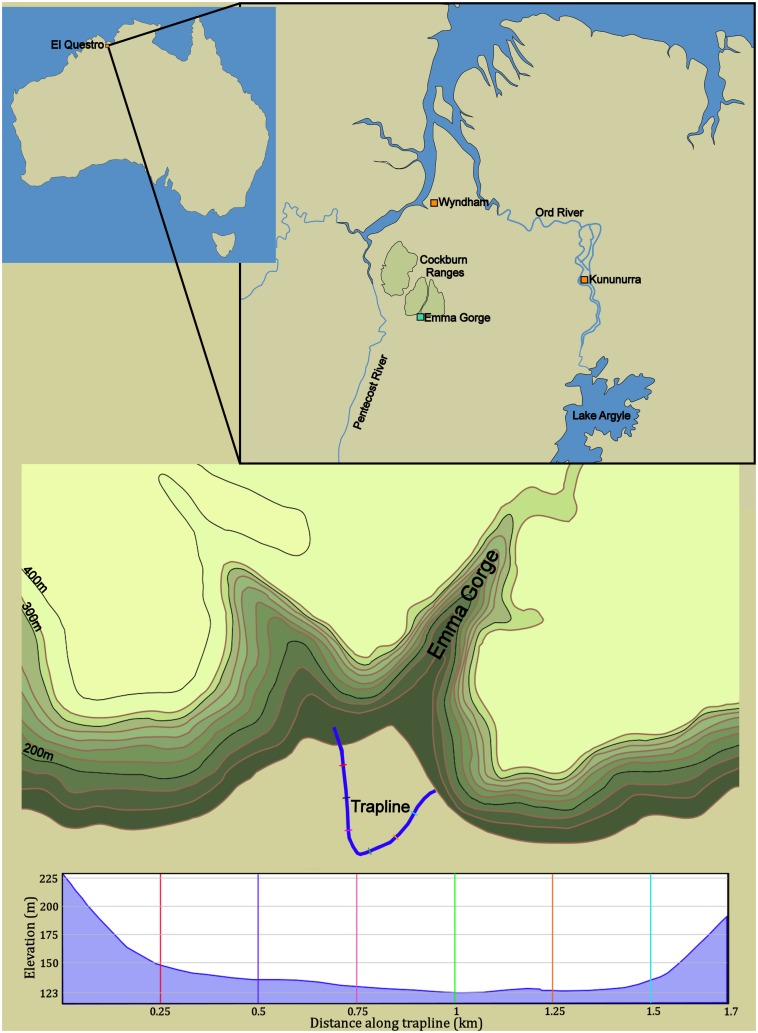
Study area, showing the 1.7 km-long pitfall trapline across the entrance to Emma Gorge, in Questro Wilderness Park, in northern Western Australia.Colors link points along the trapline with the elevation profile.